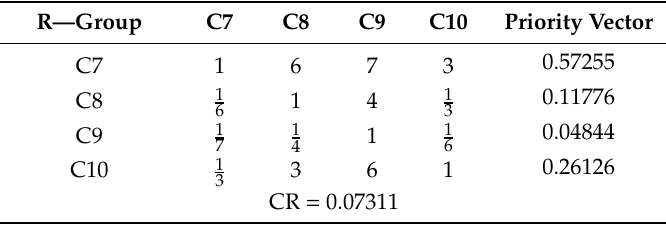
Table 6. Comparison matrix for External Risk Factors criteria group.